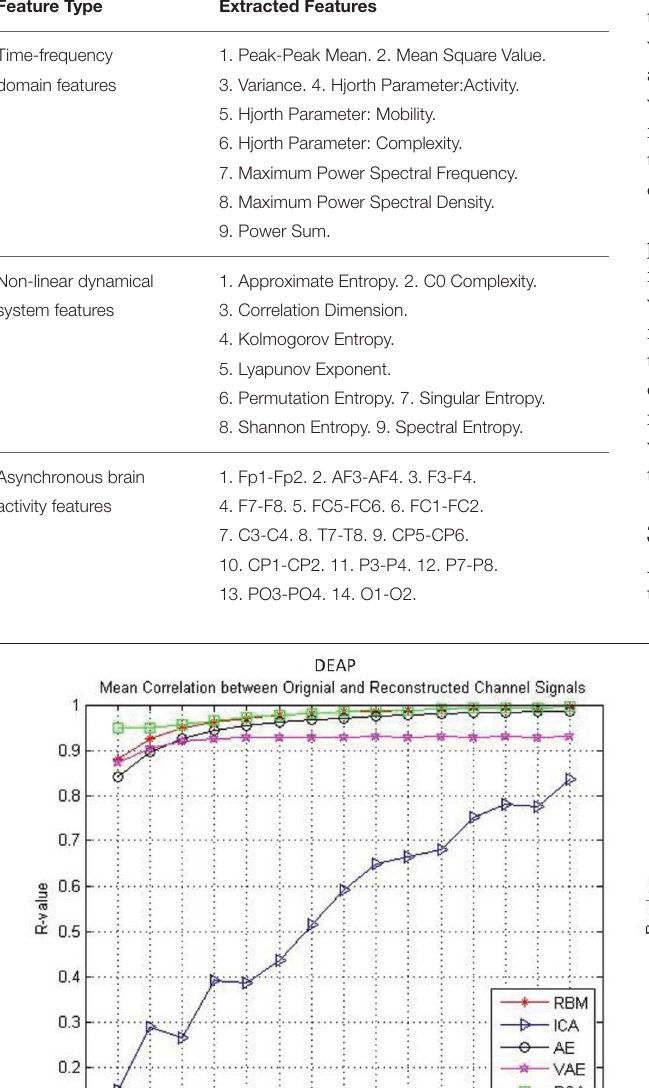
TABLE 1 | Three main categories of EEG features that we extracted for baseline methods. Feature Type